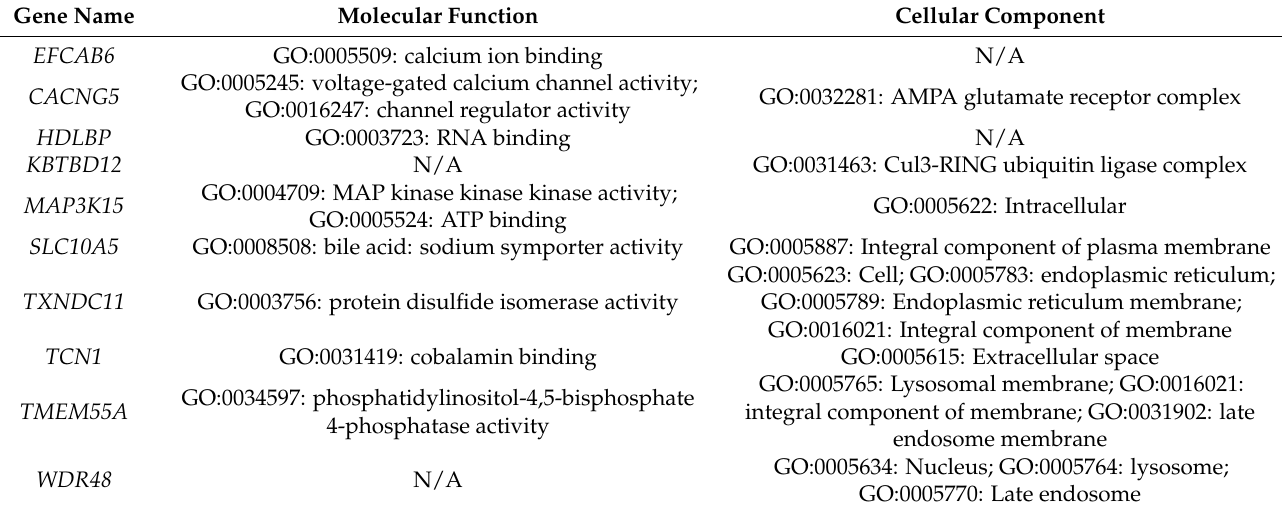
Table 3. Gene Ontology for DMRs identified in CON vs. RES